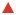
Antimony susceptibility of promastigotes and amastigotes form of Leishmania species responsible collected in human (visceral or cutaneous leishmaniasis) in dogs (CanL), rodent (L. Rodent) and sandflies (L. Phleb).SbIII Susceptibility of isolates from human CL and VL, dogs (CanL), rodent (L. Rodent) and sandflies (L. Phleb) (A). SbV Susceptibility of isolates from human CL and VL, and dogs (CanL) (B). Frequency of S- Leishmania isolates from human CL and VL, and Dogs (CanL) (IC50 above the calculated SbIII or Sb(V)-ECOFF values) (C). In vitro SbIII susceptibility of L. major, L. killicki, L. infantum parasites. L. infantum isolated from humans VL(▲) human CL (◆) or dogs (▲) (D). In vitro SbV Susceptibility of intramacrophagic amastigotes of L. major, L. killicki and L. infantum, from human VL (▲) CL (▲) or Dogs (▲) (E). Frequency of S- Leishmania isolates of L. major, L. killicki or L. infantum (IC50 above the calculated SbIII or Sb(V)-ECOFFvalues) (F).